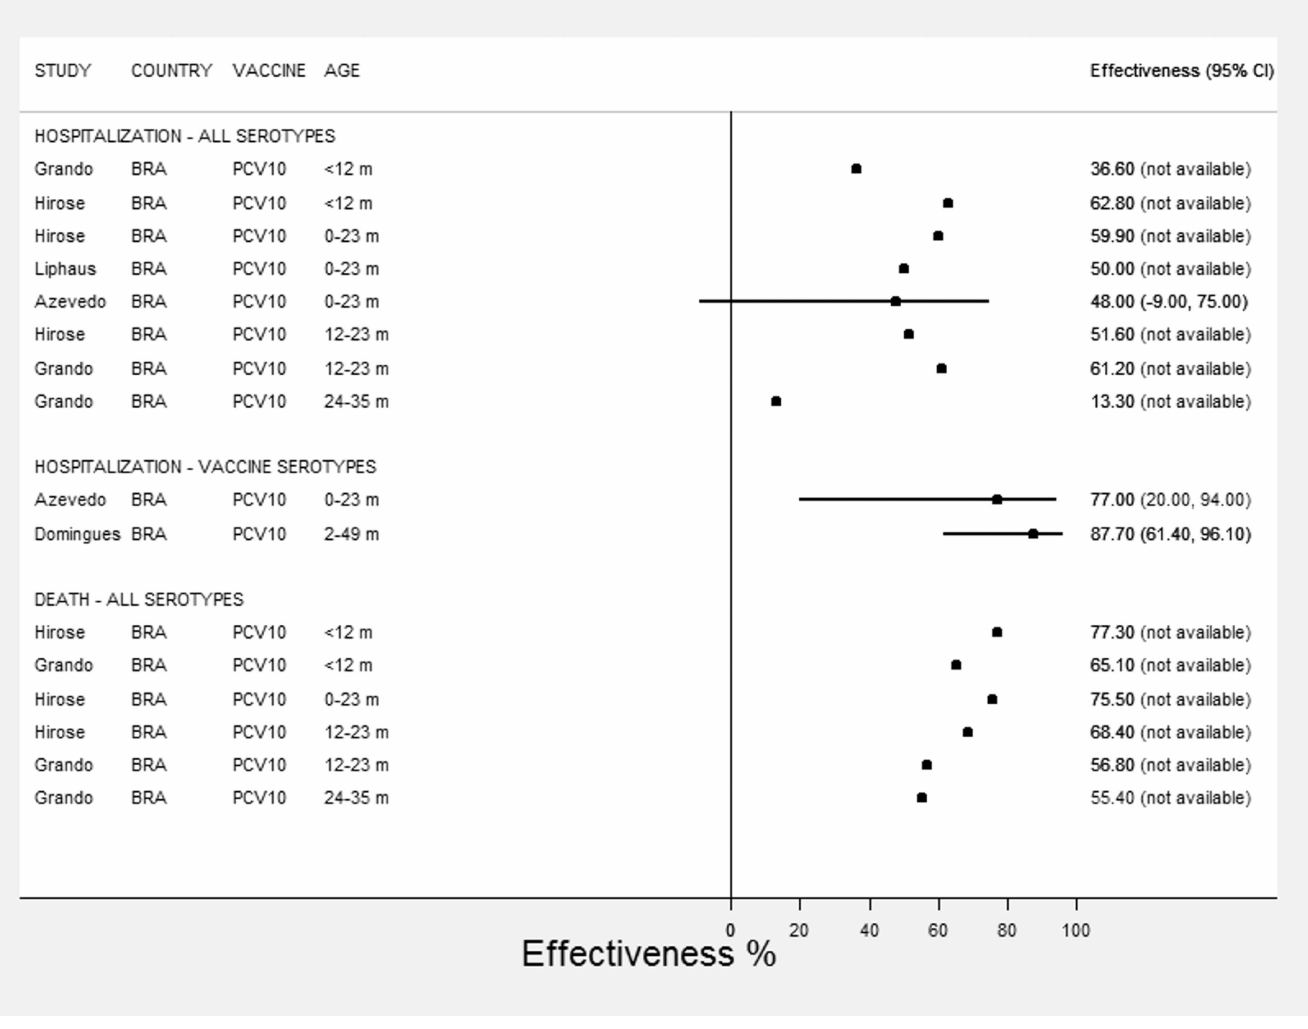
PLOS ONE | DOI:10.1371/journal.pone.0166736 December12,